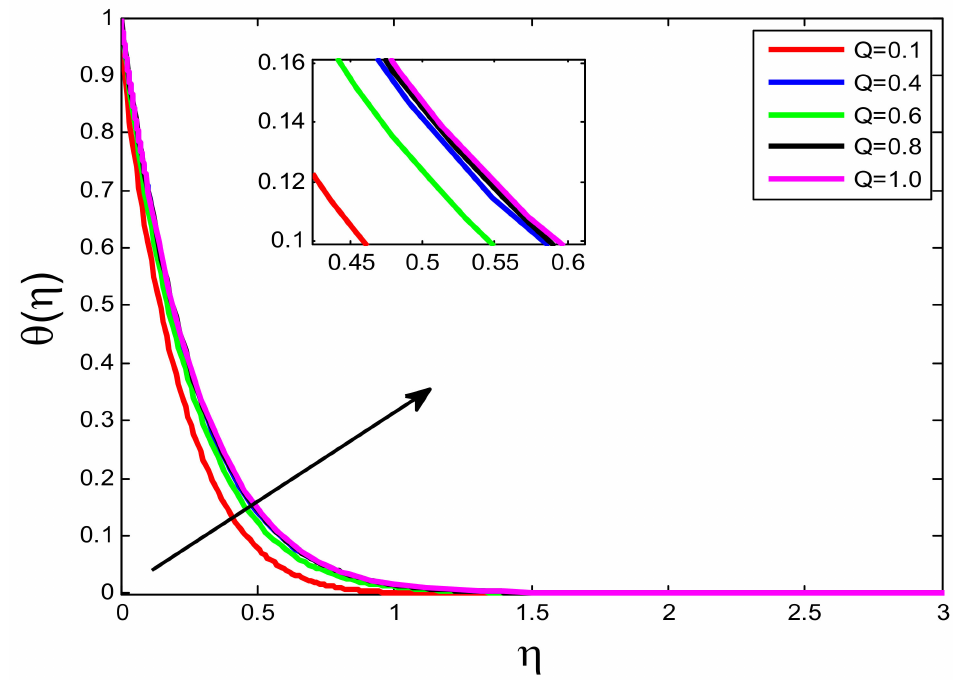
Figure 26. Influence of Q on θ ( η ) .